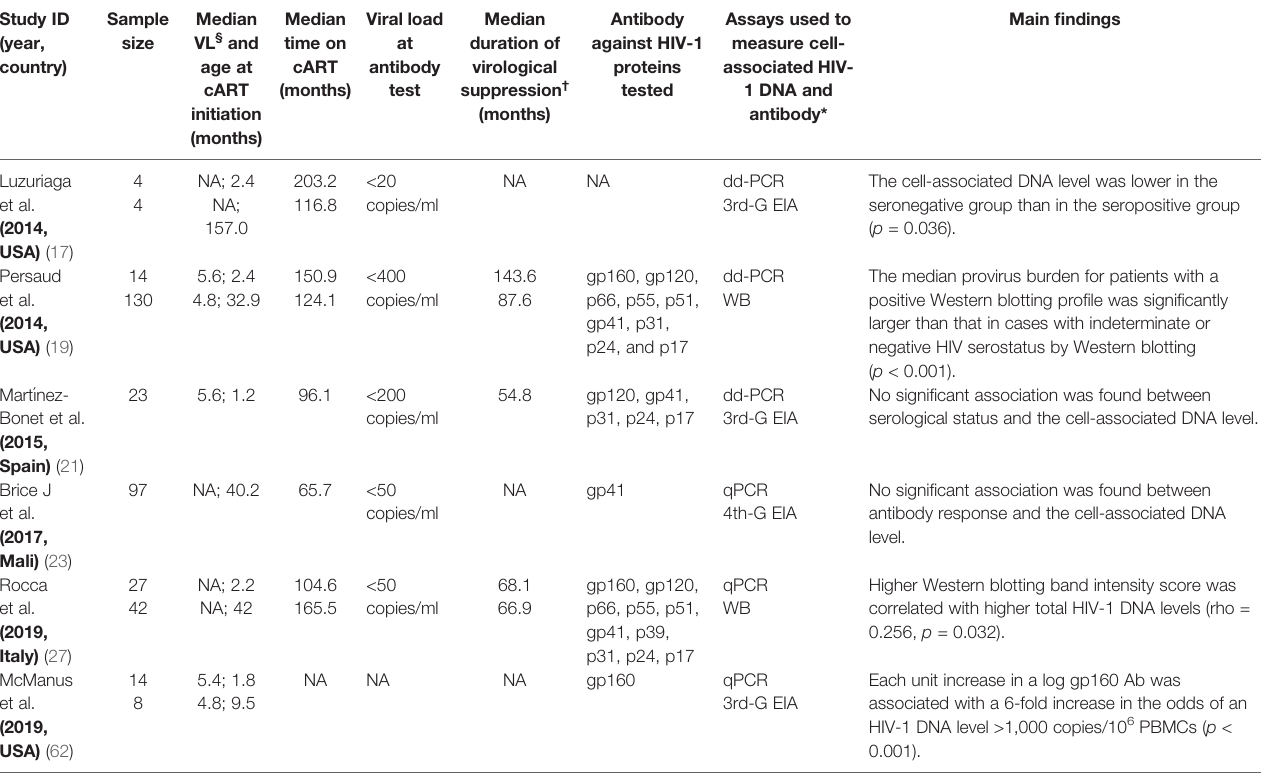
TABLE 6 | Estimated statistical association between cell-associated HIV-1 DNA burden and quantitative or qualitative anti-HIV antibody in children with vertically HIV-1 infection.